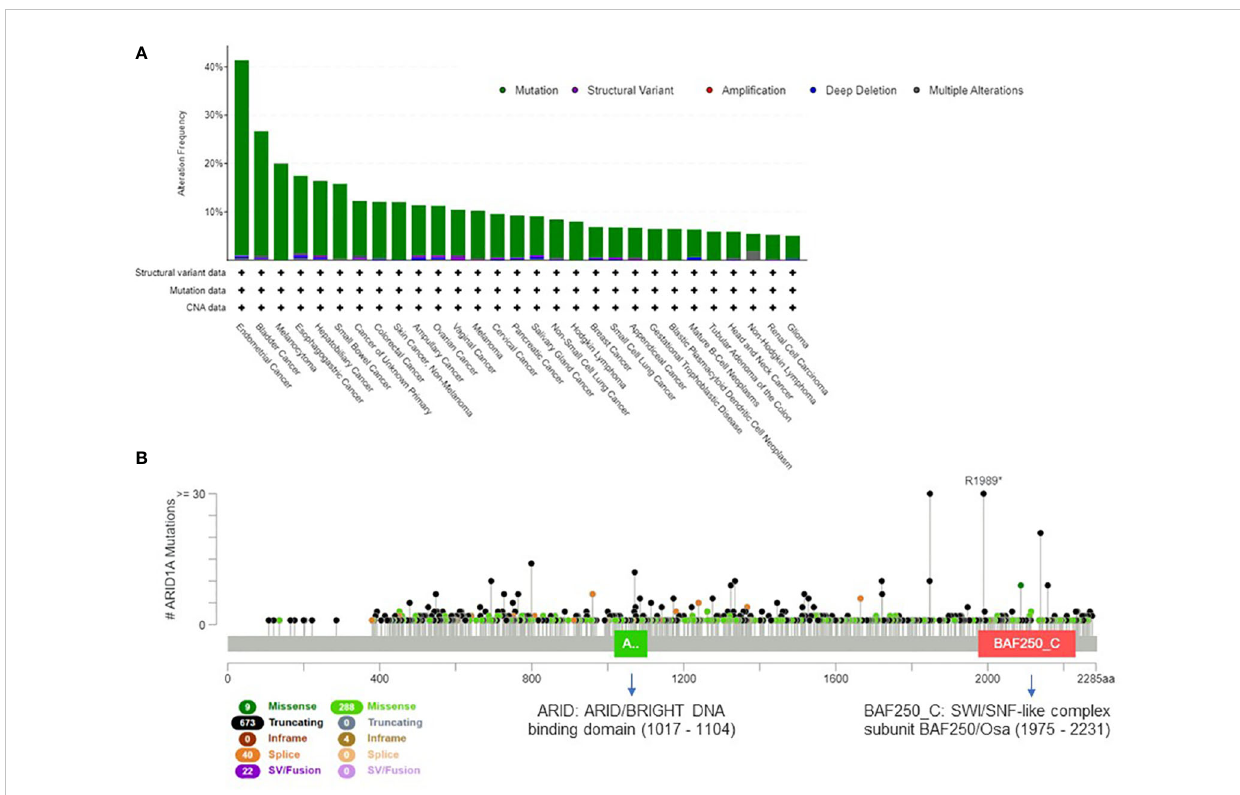
FIGURE 1 Extent of ARID1A involvement in human cancers. (A) Histogram showing ARID1A alteration frequency in 153.554 samples from the AACR GENIE project (39) and the alteration type across human cancers (minimum frequency cutoff at 5%). (B) Type, frequency and distribution of ARID1A mutations on the gene coding sequence across all AACR GENIE project tumor